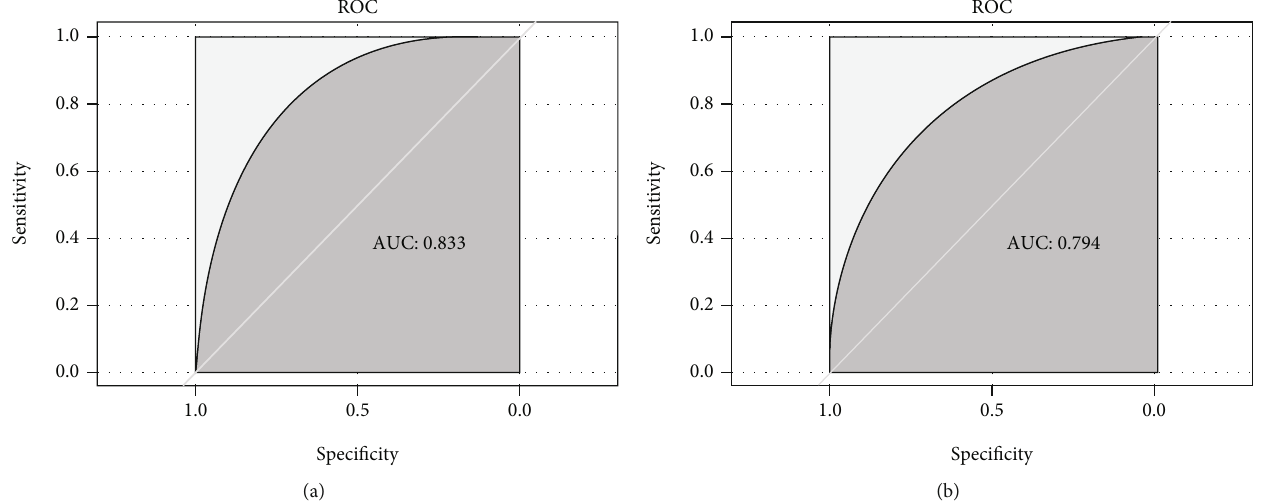
Figure 3: The ROC curves of the clinical predictive model are plotted based on the training set (3A) and validation set (3B). ROC: receiver- operating characteristic; AUC: area under the receiver-operating characteristic.